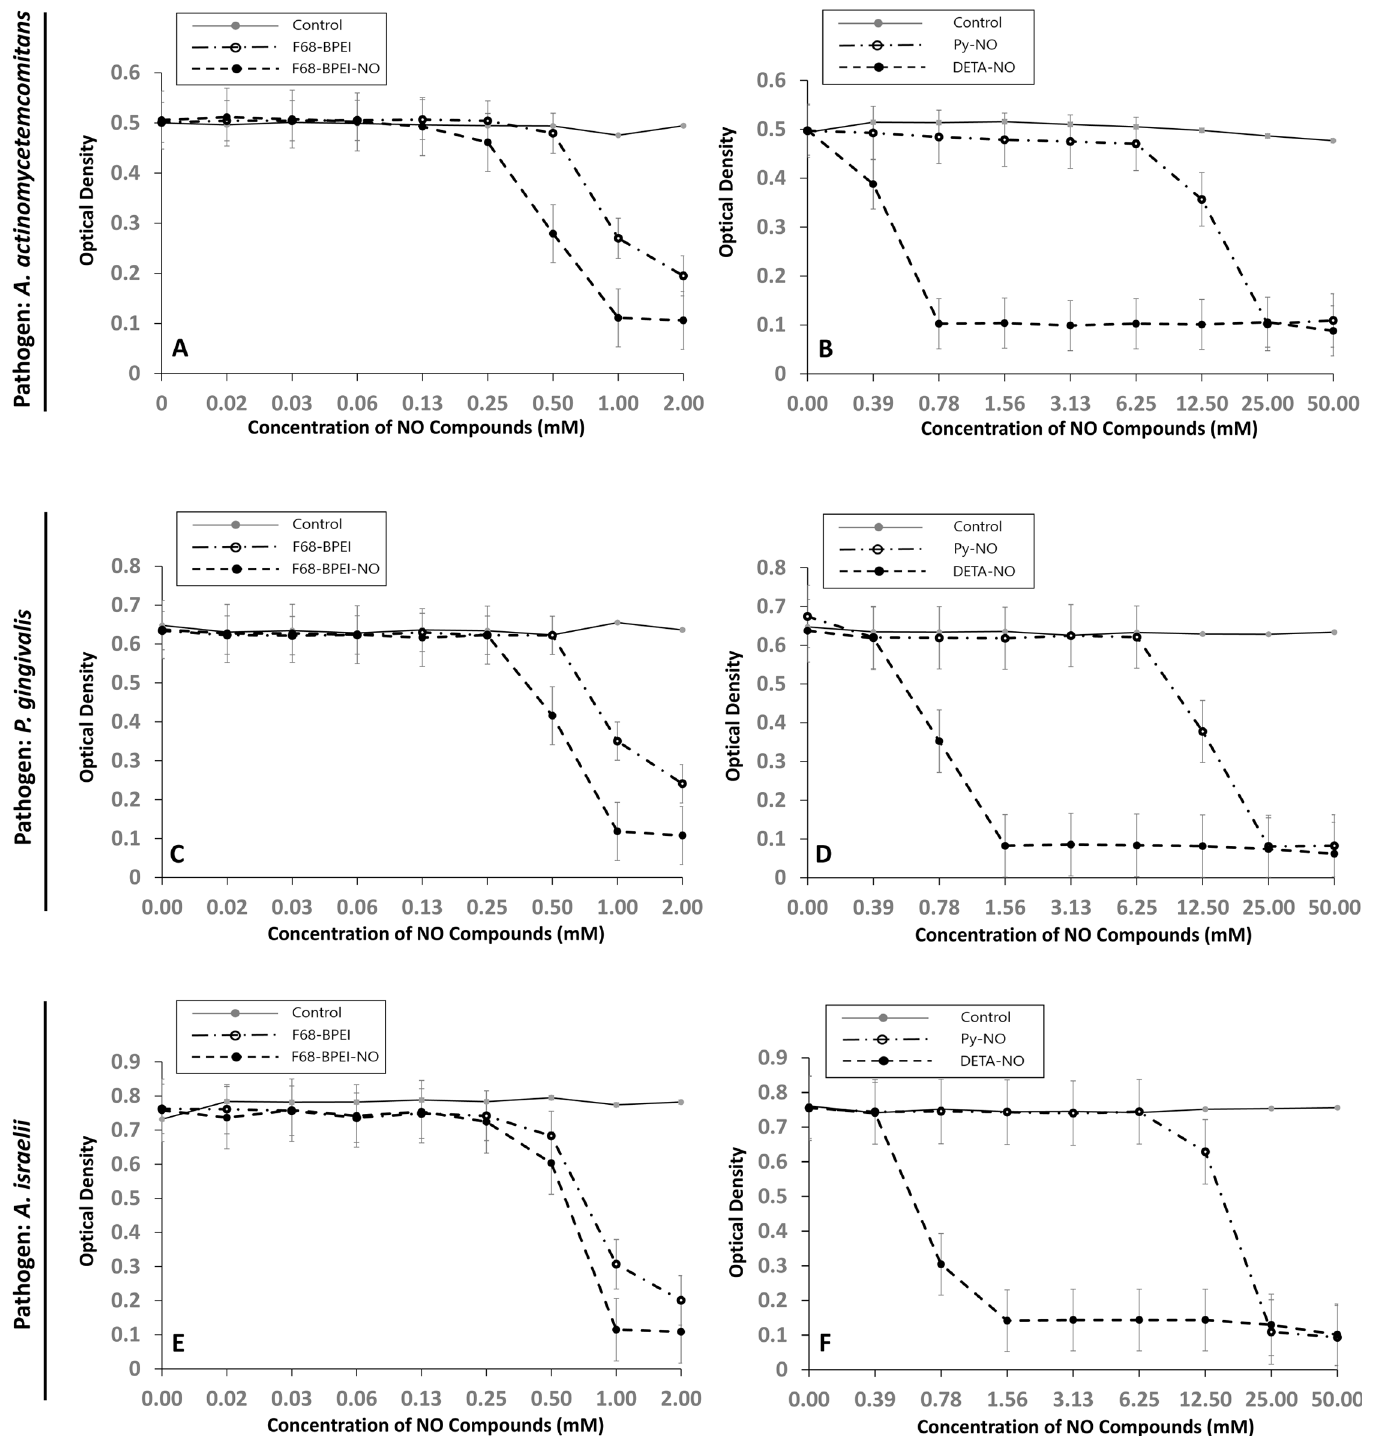
Fig 2. Bactericidal efficacy of NO-releasing